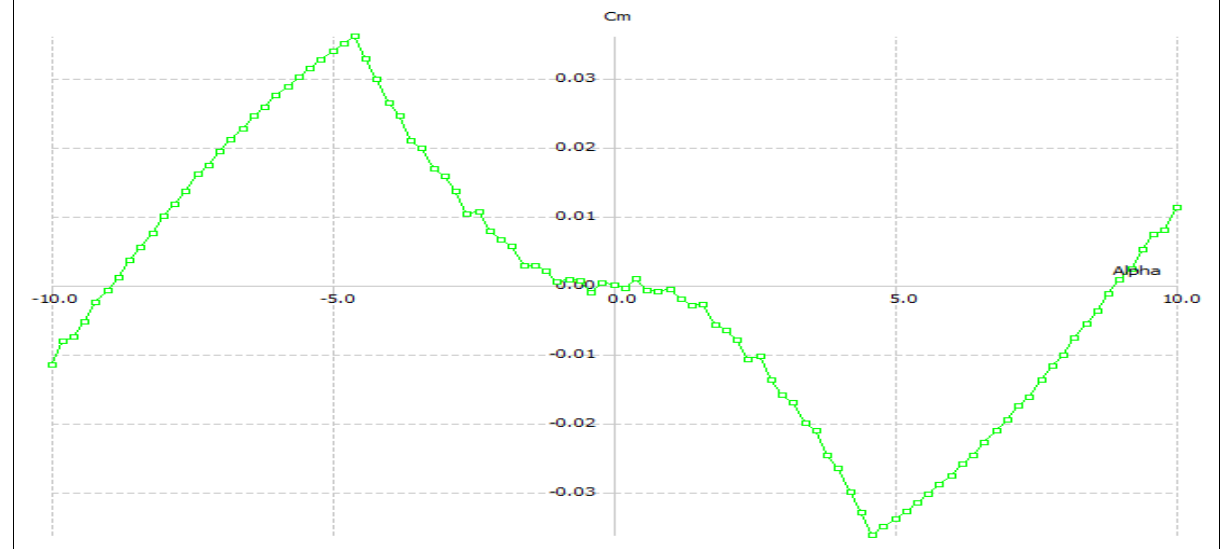
Figure 18. Cm vs Alpha for 2 Bladed VAWT